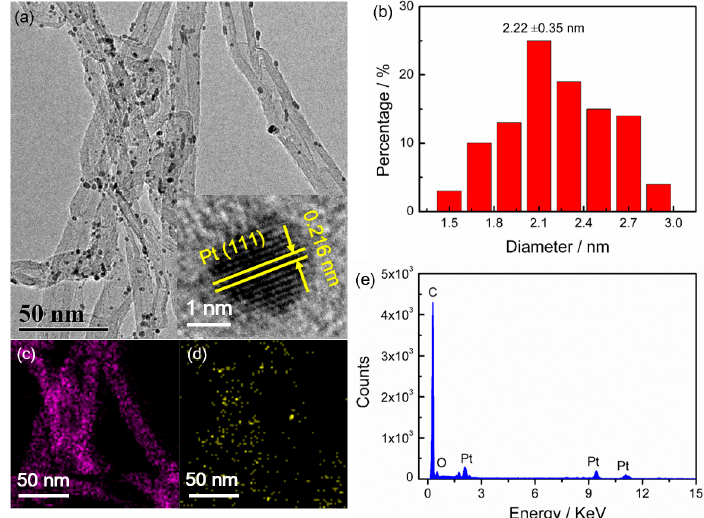
Figure 2. ( a ) Transmission electron microscope (TEM) image; ( b ) histograms of Pt NCs size distribution; ( c ) C mapping; ( d ) Pt mapping and ( e ) Energy dispersive X-ray spectroscopy (EDS) spectrum of Pt NCs/CNTs-10%.